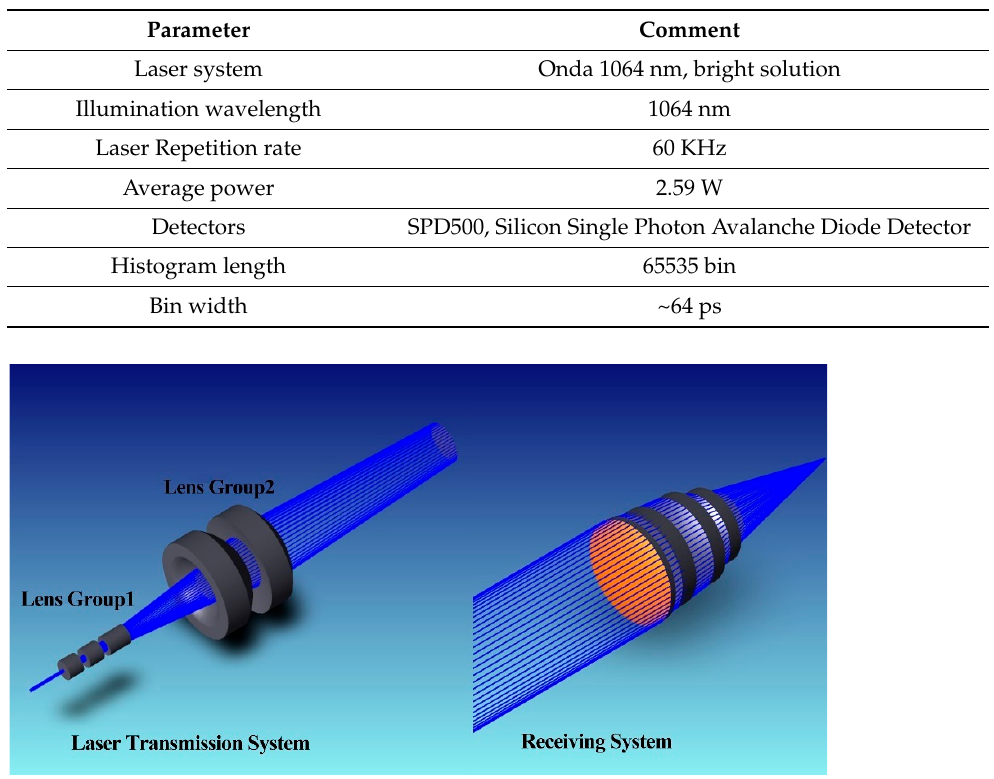
Table 1. Comment parameters for the detection system.